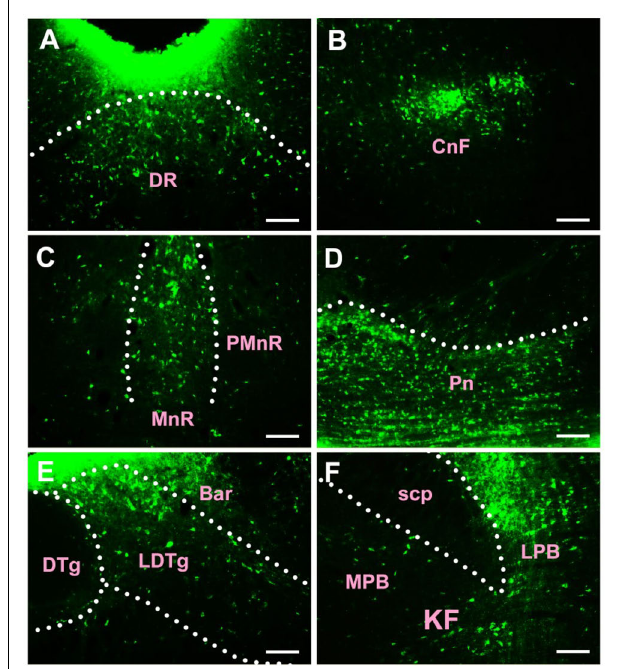
FIGURE 5 | The distribution of neurons labeled by CB in the pons (A–F) . DR, dorsal raphe nucleus; CnF, cuneiform nucleus; MnR, median raphe nucleus; PMnR, paramedian raphe nucleus; Pn, pontine nuclei; DTg, dorsal tegmental nucleus; LDTg, laterodorsal tegmental nucleus; Bar, Barrington’s nucleus; scp, superior cerebellar peduncle; LPB, lateral parabrachial nucleus; MPB, medial parabrachial nucleus; KF, Kolliker Fuse nucleus. Scale bar = 100 µ